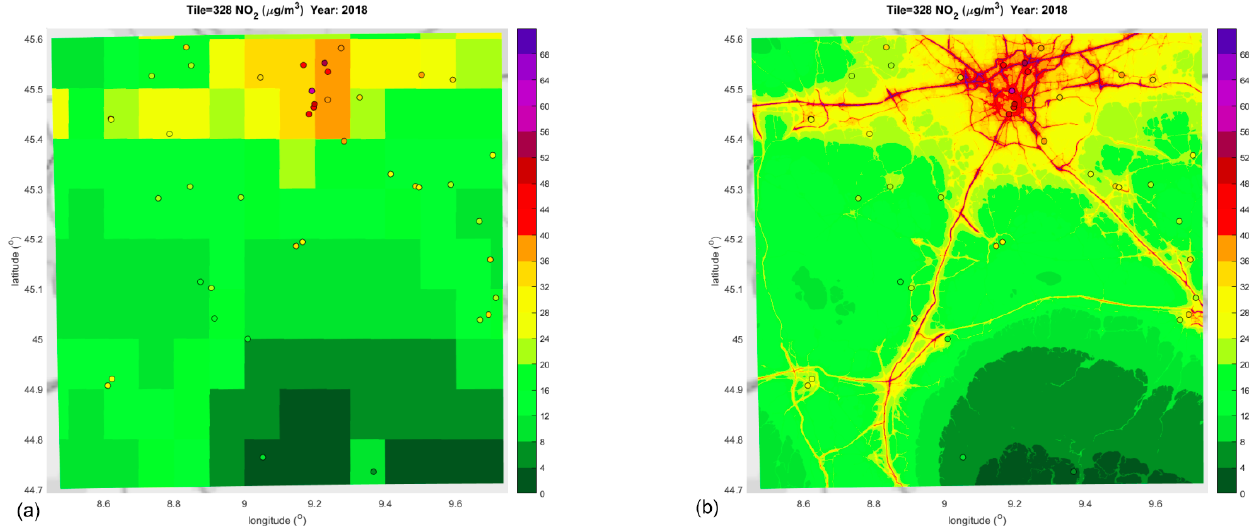
Figure 4. Calculated NO 2 concentrations in the 100km tile (no. 328) for 2018, which is part of the all European calculation at 100m resolution. (a) The EMEP model calculation at 0.1 ◦ and (b) the uEMEP calculation at 100m resolution. The city in this tile is Milan. AIRBASE stations are shown as circles.